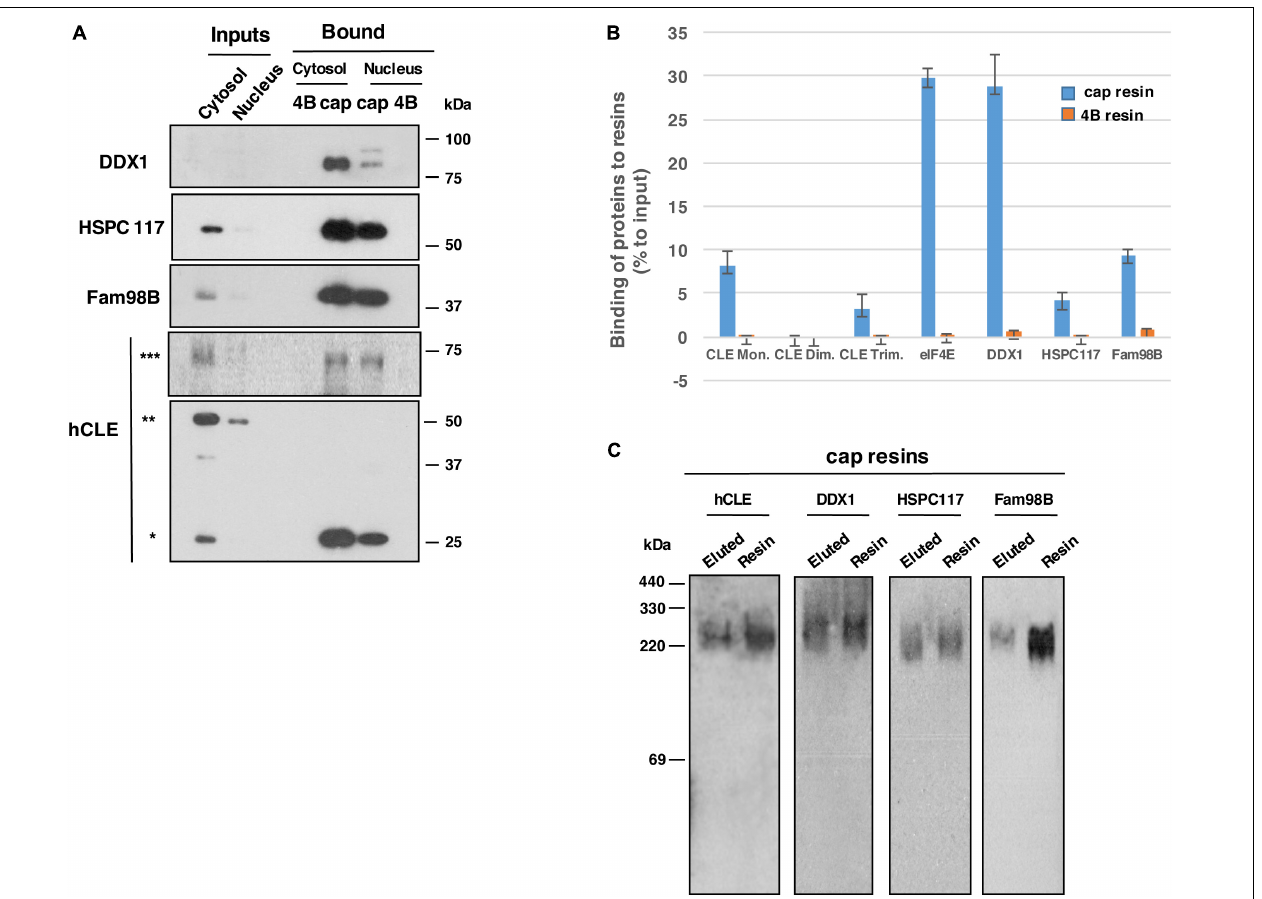
FIGURE 1 | Endogenous hCLE complexes bind cap analog resins. (A) Nuclear and cytoplasmic extracts of HEK293T cells were incubated with control (4B) or cap analog (cap) resins. Western blot analysis of bound proteins using the corresponding antibodies are shown. (B) Graph showing the percentage of the indicated proteins bound to m 7 GTP analog resin (blue) or control resin (yellow), compared to the initial input that was incubated with the corresponding resins. Total extracts and the data of three independent experiments were used. (C) Total protein extracts from HEK293T cells were incubated with cap analog resin and eluted with 1 mM m 7 GTP. Eluted fractions and resin-bound proteins were resolved in non-denaturing gels and analyzed by Western blot with indicated antibodies. ∗ monomer, ∗∗ dimers, and ∗∗∗ trimers. Cap-binding experiments were repeated more than five times. Input:bound protein ratios were: 1:12 in total and cytoplasmic HEK293T cell extracts; 1:6 in HEK293T cell nuclear